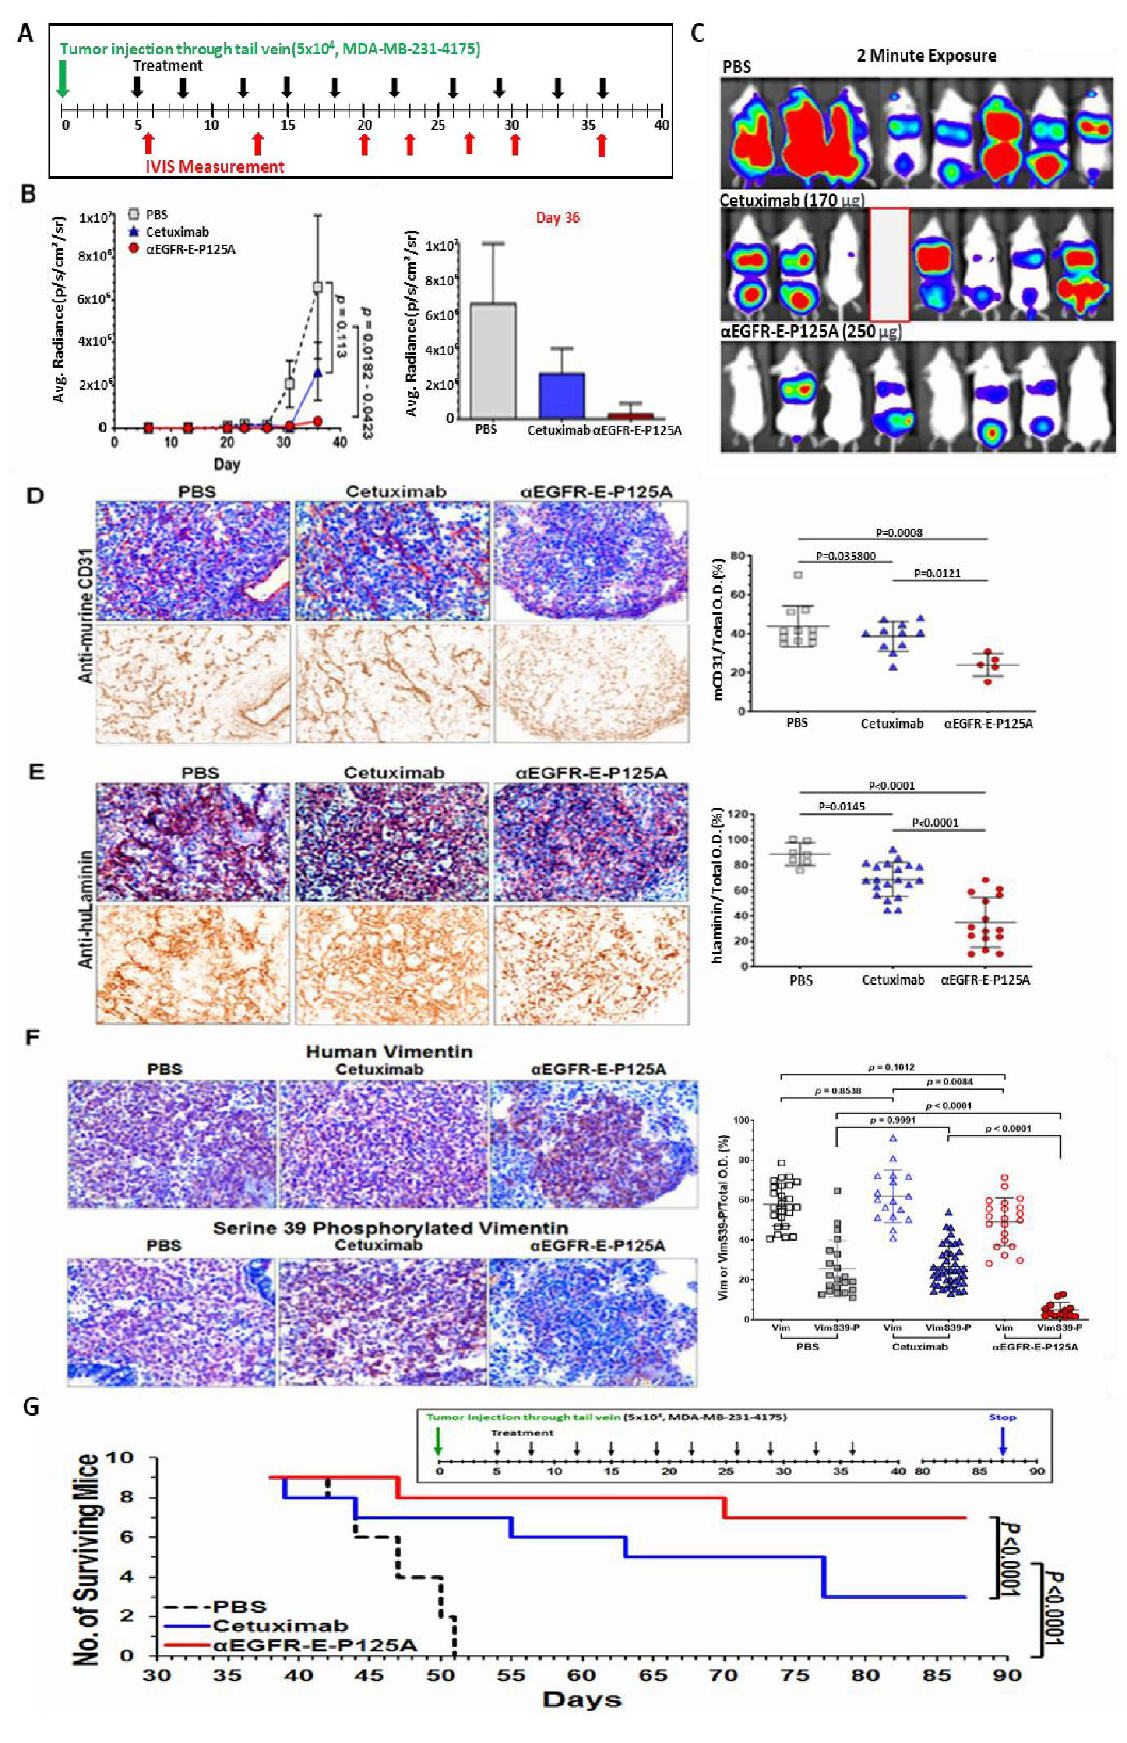
Figure 5. ( A – F ) α EGFR IgG1-huEndo-P125A inhibits pulmonary tropic MDA-MB-231-4175 lung metastasis. ( A )